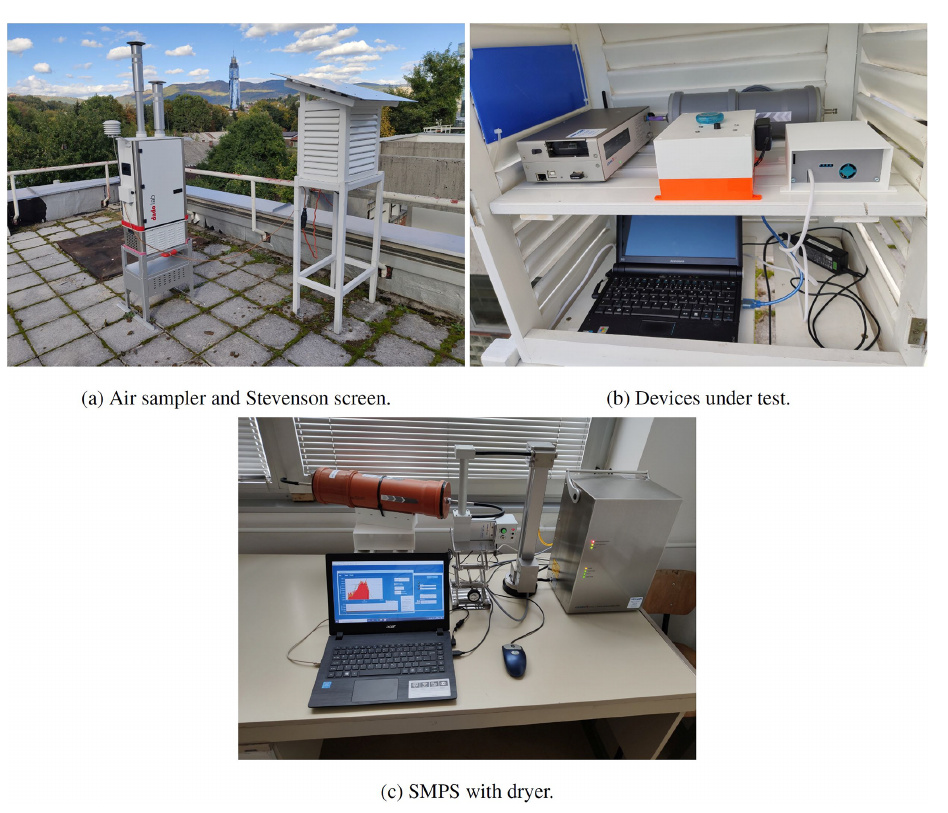
Figure 1. Experimental setup: (a) colocated air sampler and Stevenson screen; (b) devices under test inside of the Stevenson screen: 11-D with dryer, OPC-N2 with SPI adapter and (white-orange) enclosure, MAQS (white enclosure with grey front panel), and (c) indoor SMPS with dryer.